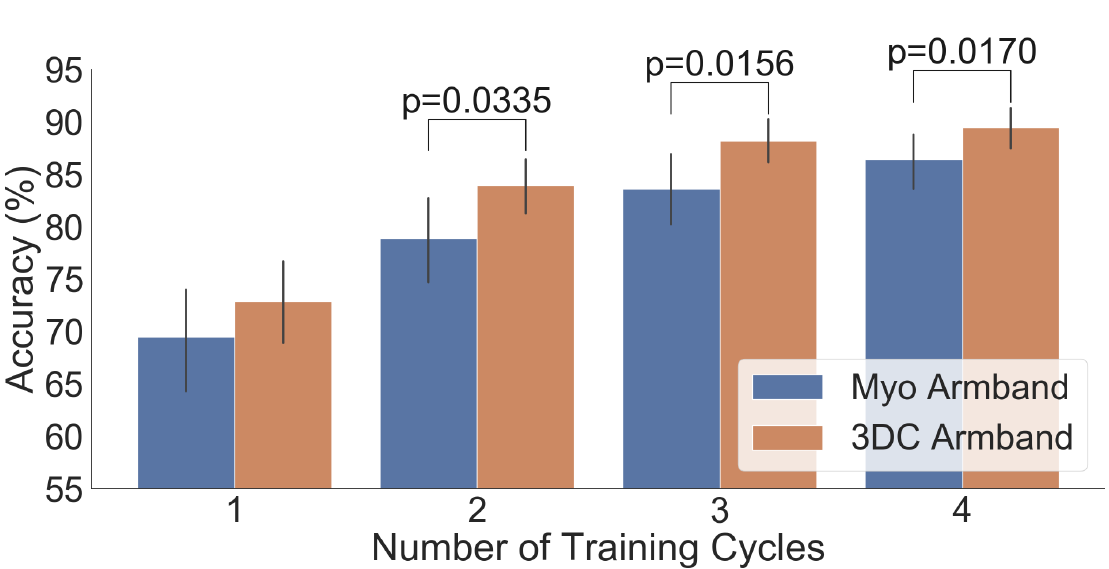
Figure 13. Comparison between the Myo and the 3DC Armband employing Raw ConvNet for classification: The number of cycles corresponds to the amount of data employed for training (one cycle equals 5 s of data per gesture). The Wilcoxon Signed Rank test is applied between the Myo and the 3DC Armband. The null hypothesis is that the median difference between pairs of observations (i.e., accuracy from the same participant with the Myo or the 3DC Armband) is zero. The p-value is shown when the null hypothesis is rejected (significant level set at p = 0.05). The black line represents the standard deviation calculated across all 22 participants.